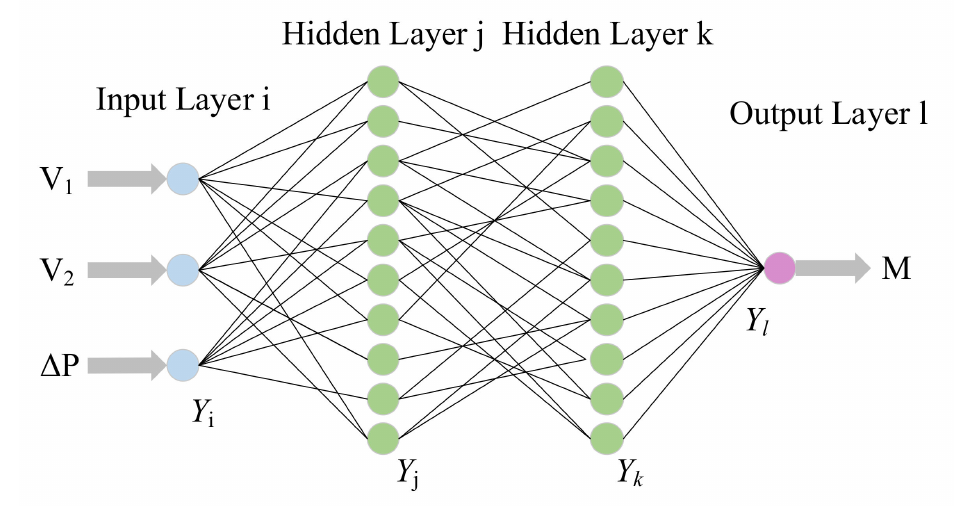
Figure 4. ANN architecture for estimating OSF value proposed in this